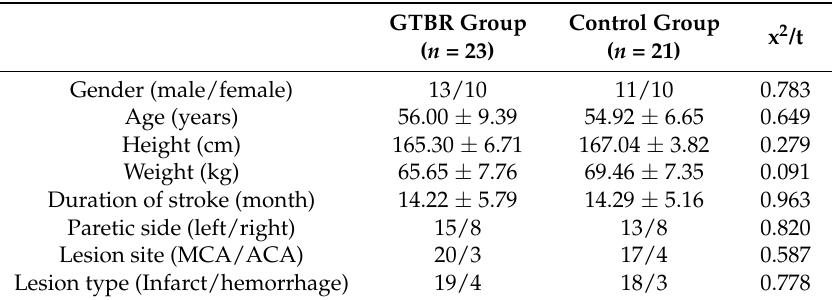
Table 1. General characteristics of subjects.